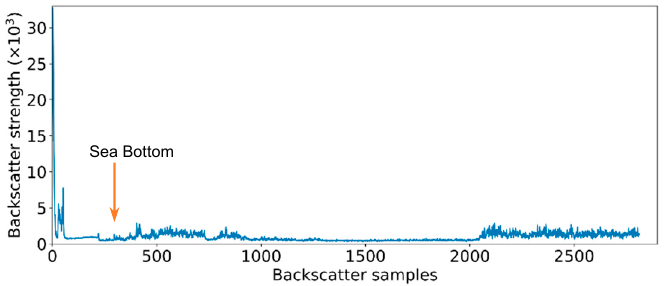
Figure 15. Backscatter strength sequence with very low signal to noise Figure 15 . Backscatter strength sequence with very low signal to noise ratio.